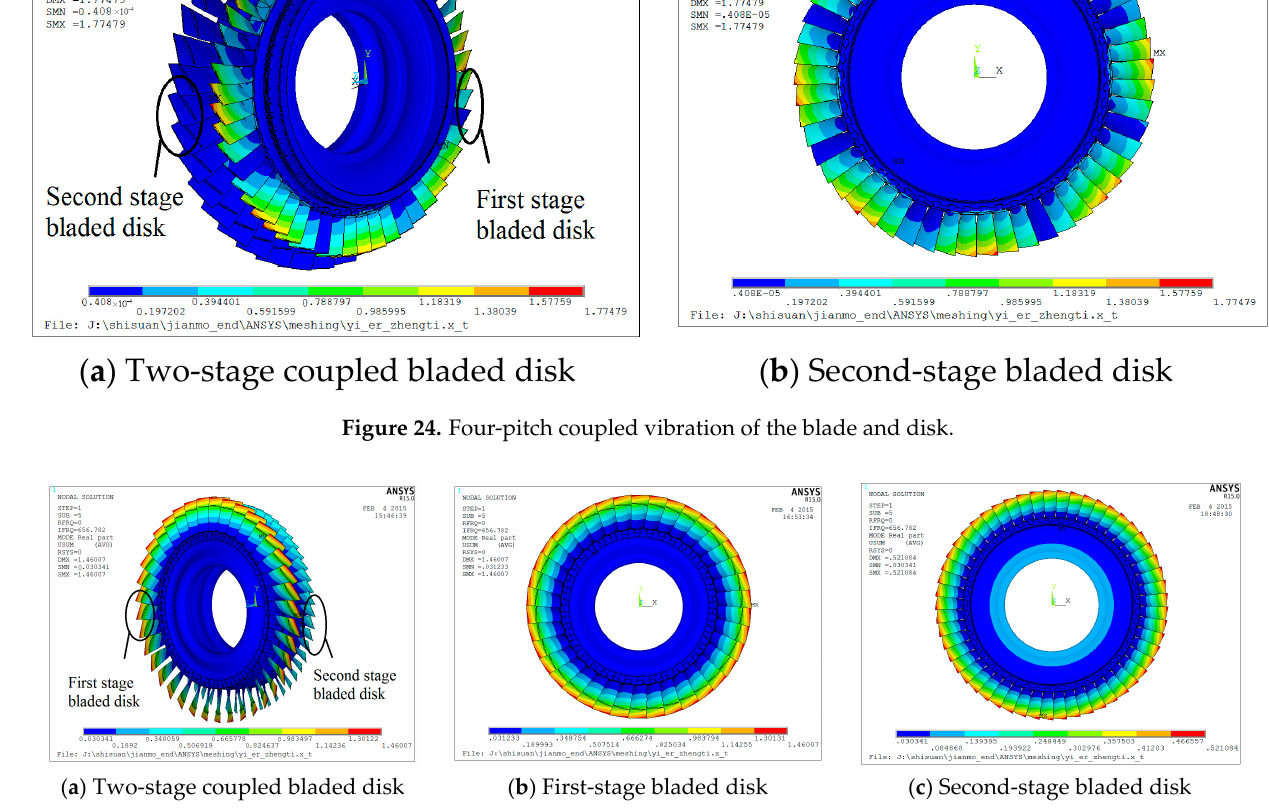
Figure 25. Coupled vibration at a natural frequency of 656.78 Hz.